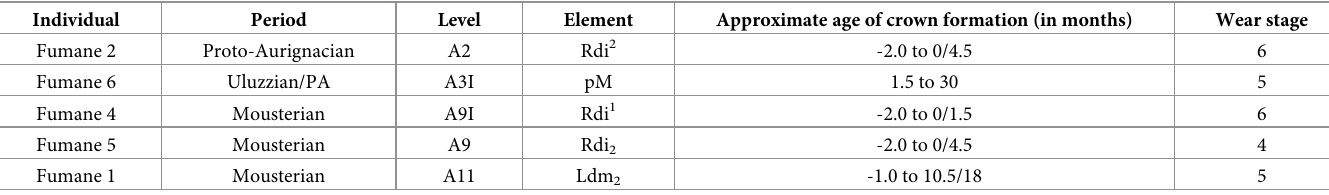
Table 1. Summary data of the five hominin teeth measured in this